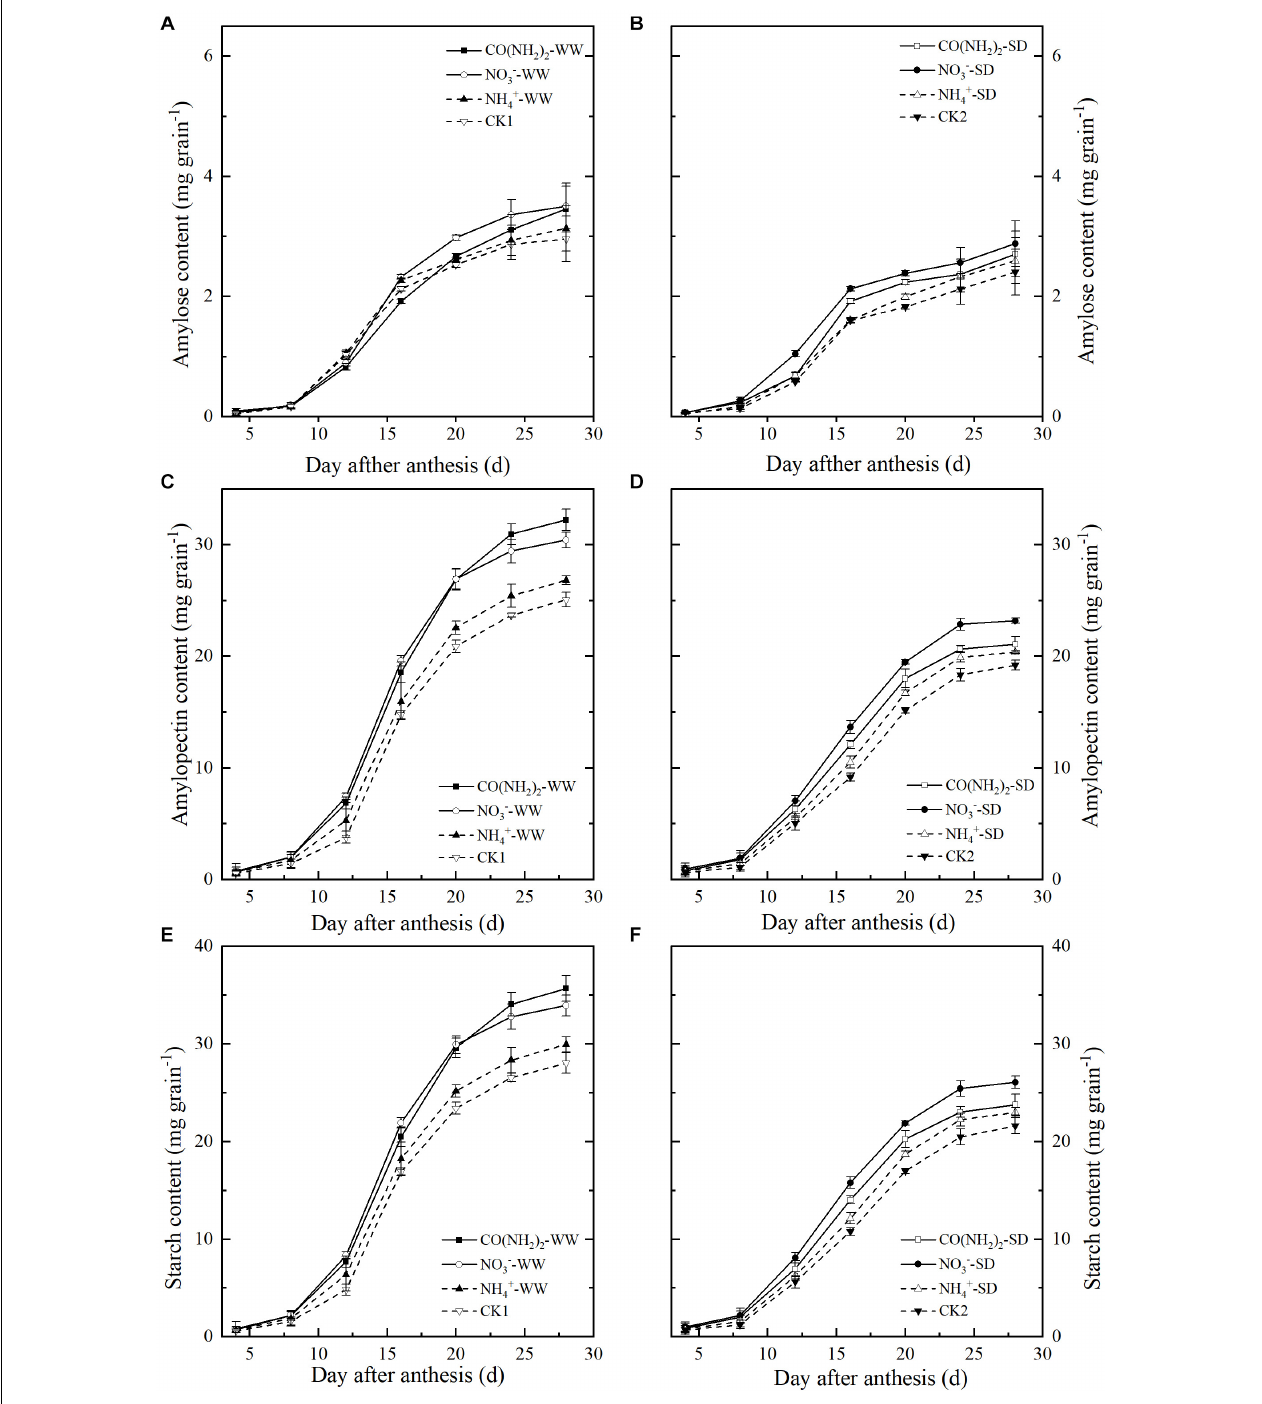
FIGURE 3 | Effect of N forms in foliar fertilizer on the amylose content, amylopectin content, and total starch content in the wheat grains [ (A,C,E) well-watered treatment, WW; (B,D,F) soil-dried treatment, SD]. Vertical bars represent ± the standard deviation of the mean ( n = 3). CO(NH 2 ) 2 , NO 3 − , and NH 4 + represent CO(NH 2 ) 2 , NaNO 3 , and NH 4 Cl, whose concentration was described in the Materials and Methods section. CK1 and CK2 mean that deionized water was sprayed on leaves at anthesis under well-watered treatment and soil-dried treatment, respectively.